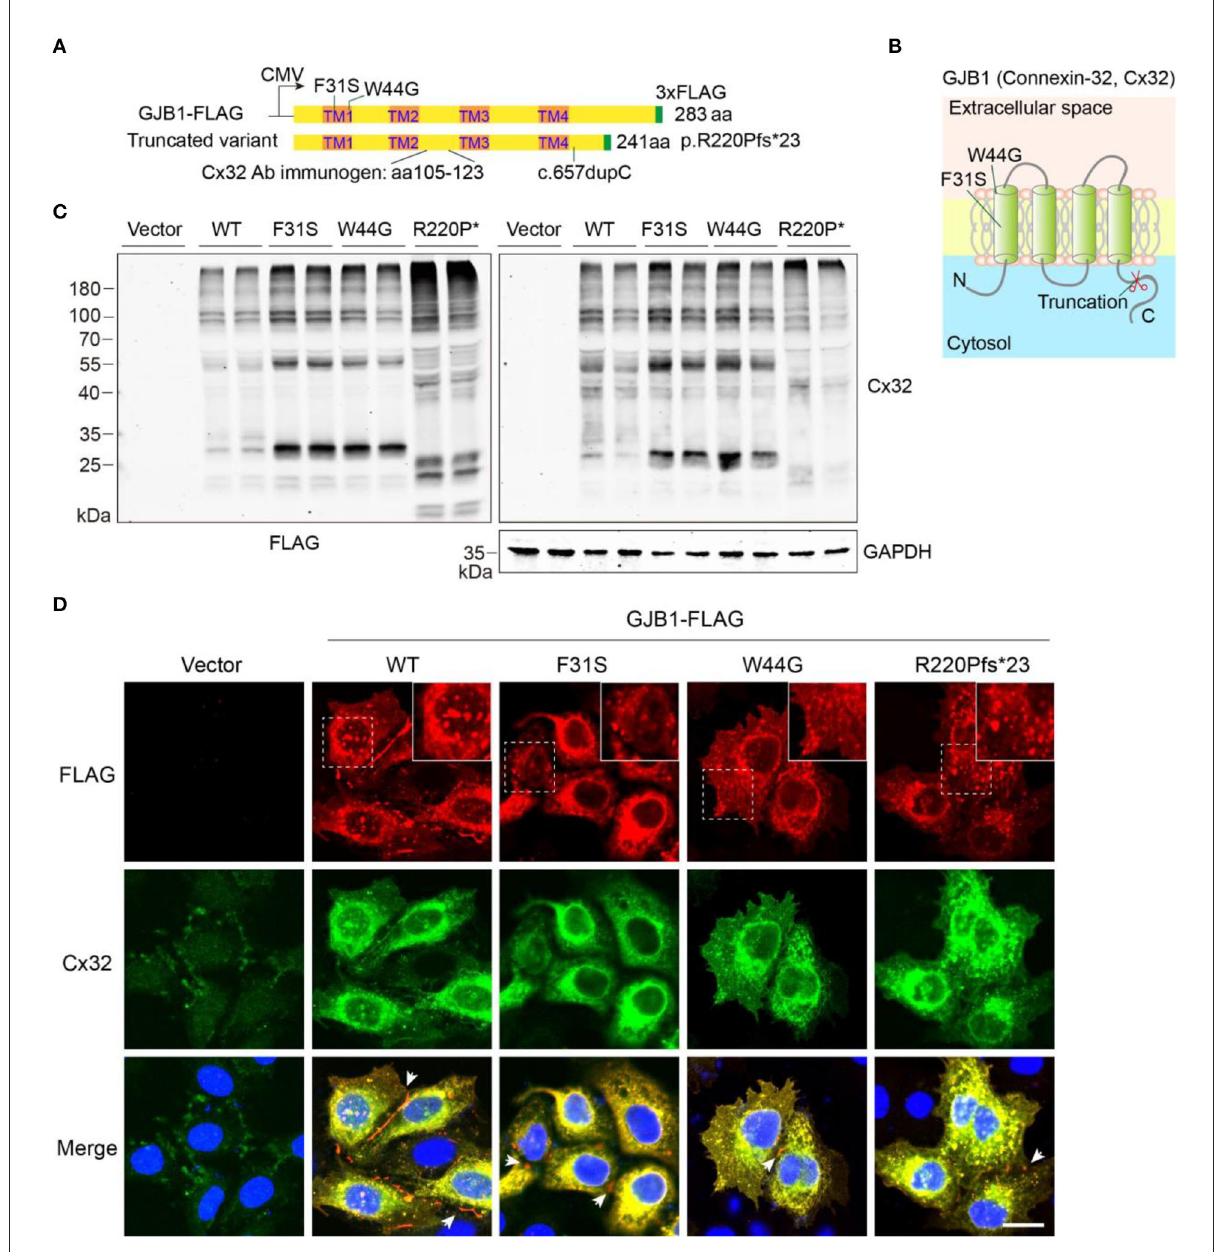
FIGURE2 Eukaryotic expression of GJB1 variants. (A) Schematic illustration of vector design and domain structure of GJB1. TM1-4 represents transmembrane (TM) helical. CMV promoter was used. Mutation sites region of the immunogen for Cx32 antibody are indicated. (B) Model of GJB1 assembly on the plasma membrane with four TM domains. (C) Immunoblots of wild-type (WT) and mutant forms of GJB1 expression in HeLa cell lysates with anti-FLAG and anti-Cx32 antibodies. Cell lysates were collected 24h after transfection. GAPDH acts as a loading control. R220P* represents truncated mutant R220Pfs*23. (D) Immunofluorescence staining of fixed HeLa cells with indicated transfection. Blue, DAPI-labeled nuclei. Enlarged views were shown at the top right corner. Arrowheads denote GJ-plaque structures that were preferentially labeled with anti-FLAG antibody. Scale bar, 20 µ